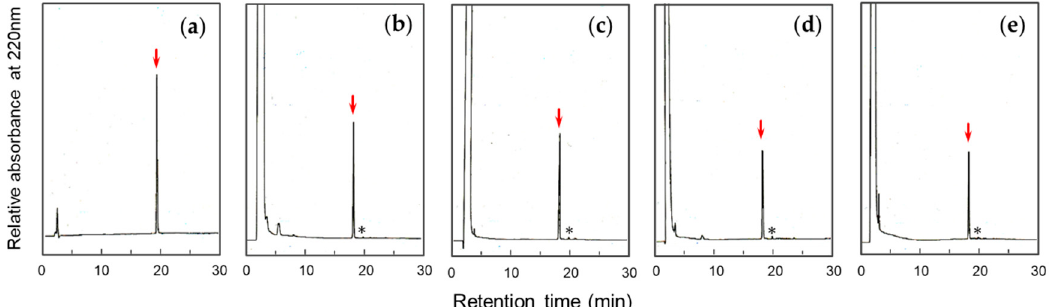
Figure 2. RP-HPLC profiles of ( a ) Acm 2 -precursor peptide and the reaction solutions after I 2 -oxidation in ( b ) 50% AcOH, ( c ) 50% MeOH/0.1 M HCl, ( d ) 50% i -PrOH/0.1 M HCl, and ( e ) 80% i -PrOH/0.1